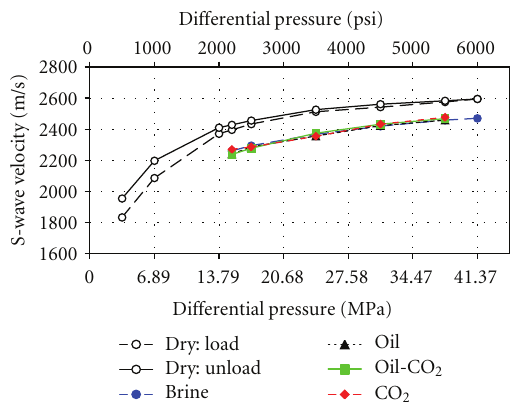
Figure 8: P- and S-wave velocities for the high-permeability number 2 sample versus di ff erential pressure for dry rock, brine saturated, and when flushed with live oil, the oil-CO 2 mixture, and CO 2 .